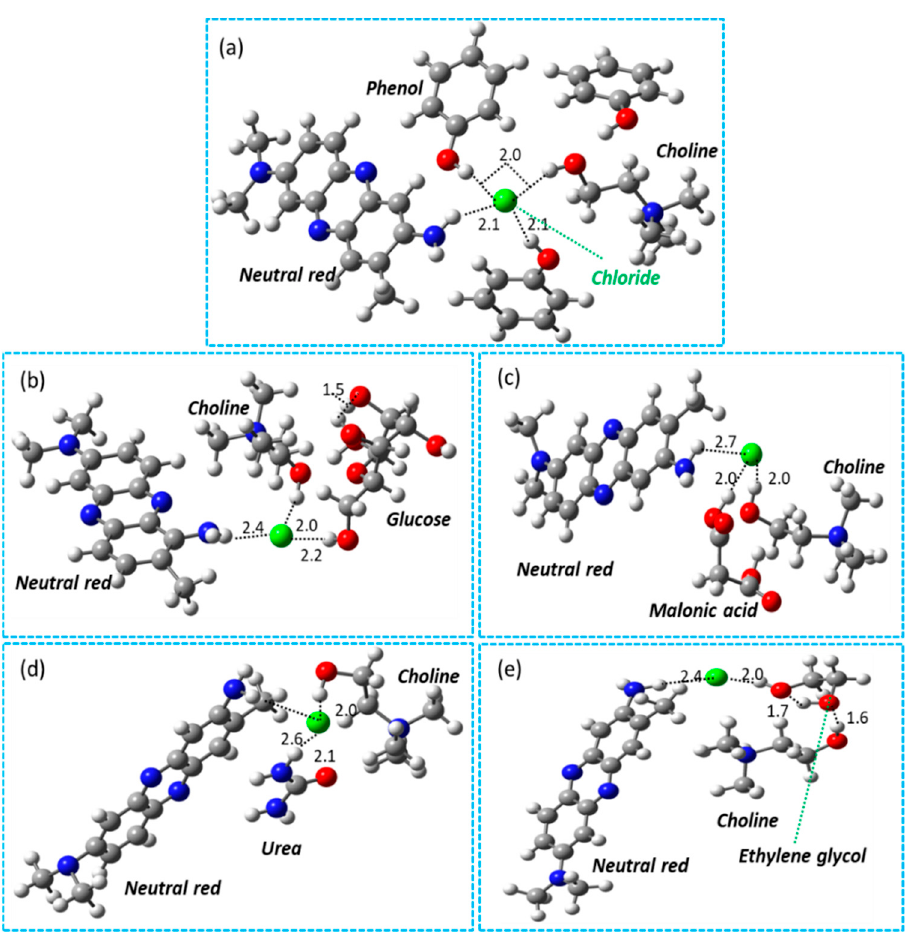
Figure 4. Representation of interaction between different DESs and NR molecules using density- functional theory (DFT) calculations. ( a ) DES (choline chloride + phenol) interaction with NR. ( b ) DES (choline chloride + glucose) interaction with NR. ( c ) DES (choline chloride + malonic acid) interaction with NR. ( d ) DES (choline chloride + urea) interaction with NR. ( e ) DES (choline chloride + ethylene glycol) interaction with NR. The gray, red, blue, green, and white colors represent the carbon, oxygen, nitrogen, chloride and hydrogen species,